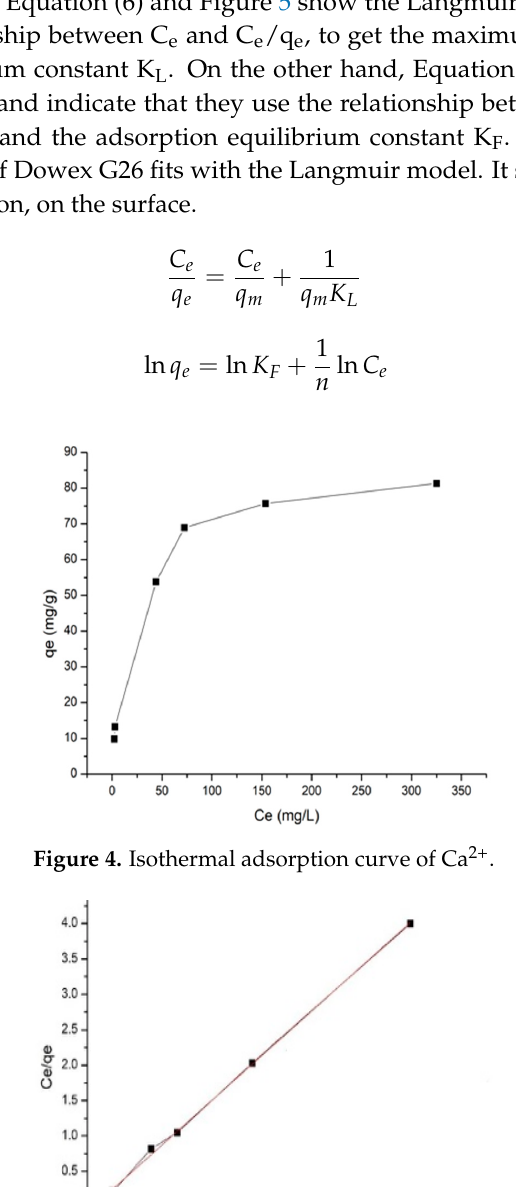
Figure 3. The yields of lithium bicarbonate solutions with different hydrogenation temperatures.